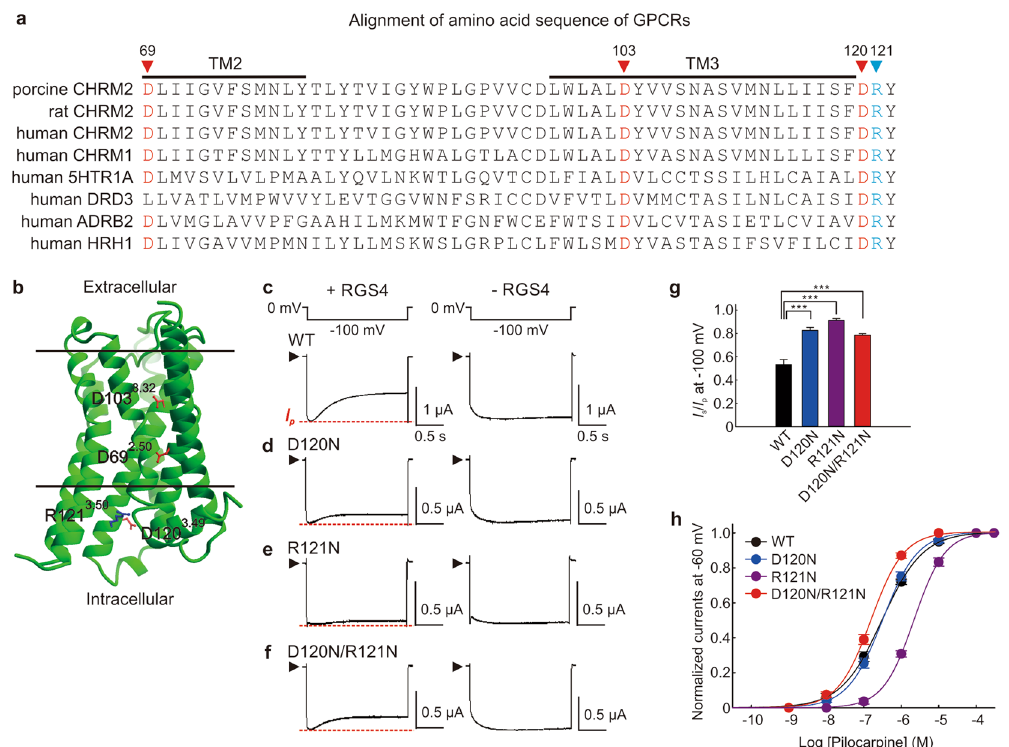
Figure 4. Charged residues in the DRY motif of the M2 muscarinic receptor contribute to the voltage- dependent response of GIRK currents. ( a ) Alignment of amino acids of different species of M2 muscarinic receptors and other human rhodopsin-like GPCRs. Triangles indicate the position of charged residues D69 2.50 , D103 3.32 , D120 3.49 and R121 3.50 . ( b ) M2 muscarinic receptor model was based on the crystal structure (PDB accession 4MQS) 27 . The charged residues that we investigated in this study are colored. ( c – f ) Pilocarpine (100 µ M)-induced GIRK currents in oocytes expressing the WT M2 muscarinic receptor ( c ) or mutants D120N ( d ), R121N ( e ) and D120N/R121N ( f ) with ( left panels ) and without ( right panels ) RGS4 were recorded at − 100 mV as shown above. ( g ) The ratio of I − 100 mV s to I p ( I s / I p ) of pilocarpine-induced GIRK current at in oocytes expressing M2 muscarinic receptor WT and mutants. ( h ) Concentration-response curves of pilocarpine-induced GIRK current were fitted with the Hill equation. The maximal value of pilocarpine- induced GIRK current was normalized to 1. The − log EC 50 was 6.51 ± 0.01 for WT; 6.81 ± 0.01 for D120N; 5.66 ± 0.01 for R121N; 6.50 ± 0.01 for D120N/R121N. Data in g and h are means ± s.e.m., n = 6–8. *** Indicates a statistically significant difference ( P ≤